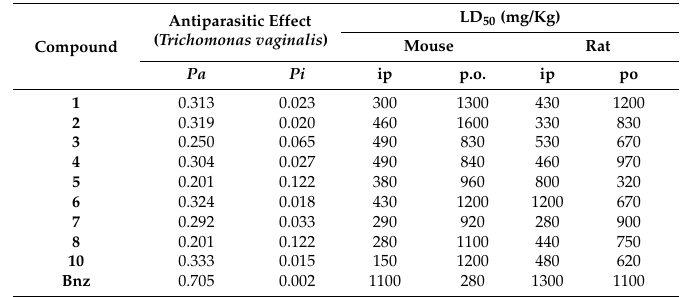
Table 1. Calculated activity and toxicity in silico profiles for compounds 1 – 8 and antiprotozoal choice drugs.